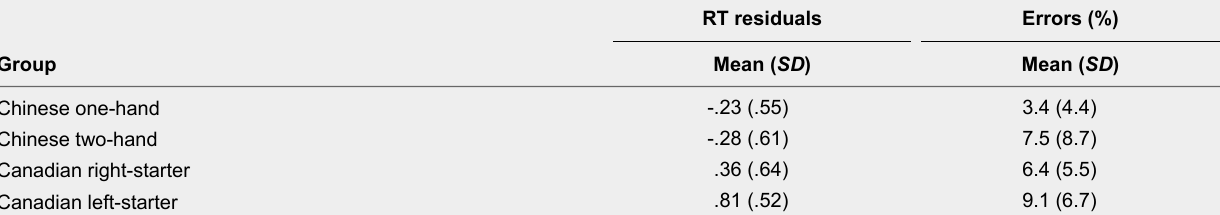
Descriptive Statistics for Two-Hand